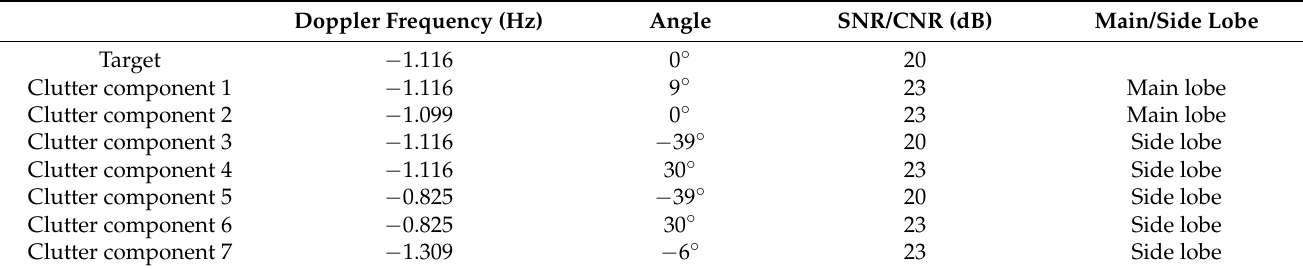
Table 2. Clutter components and target simulation parameters.